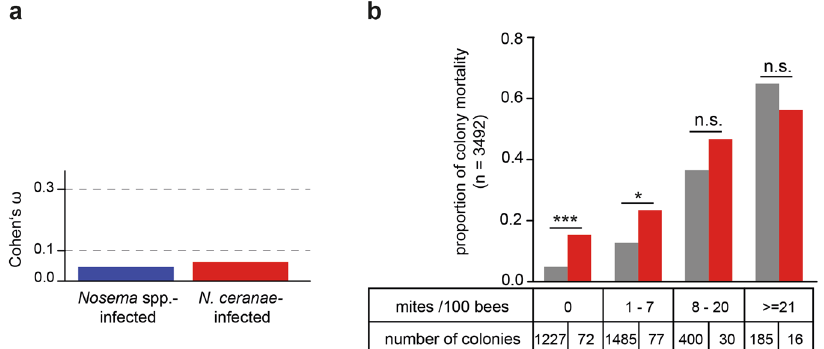
Fig. 5 Biological relevance of N. ceranae infections. a Bar plot showing the effect size Cohen ’ s ω for Nosema spp.- (blue bar) and N. ceranae -infected (red bar) colonies on colony mortality. Dashed lines indicate the conventional de fi nition of Cohen ’ s ω with a value for ω between 0.1 and 0.3 as small, between 0.3 and 0.5 as medium and above 0.5 as large effect 69 . b Bar plot showing the relation between colony mortality, mite infestation level categories (mites per 100 bees) and N. ceranae -infection status (gray bars = not infected with N. ceranae , red bars = infected with N. ceranae ). Signi fi cance levels, which resulted from p -values of the χ 2 -tests, are indicated by asterisks (n.s., p ≥ 0.05; signi fi cantly different: *0.05 < p < 0.01; **0.01 < p < 0.001; ***0.001 > p ).